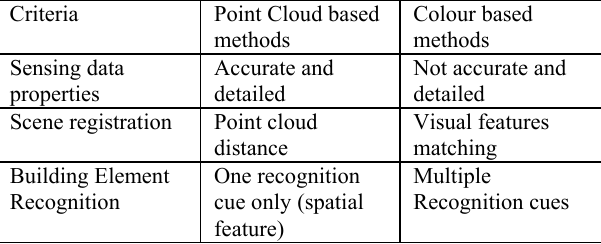
Table 3. Comparison of point cloud and colour based methods